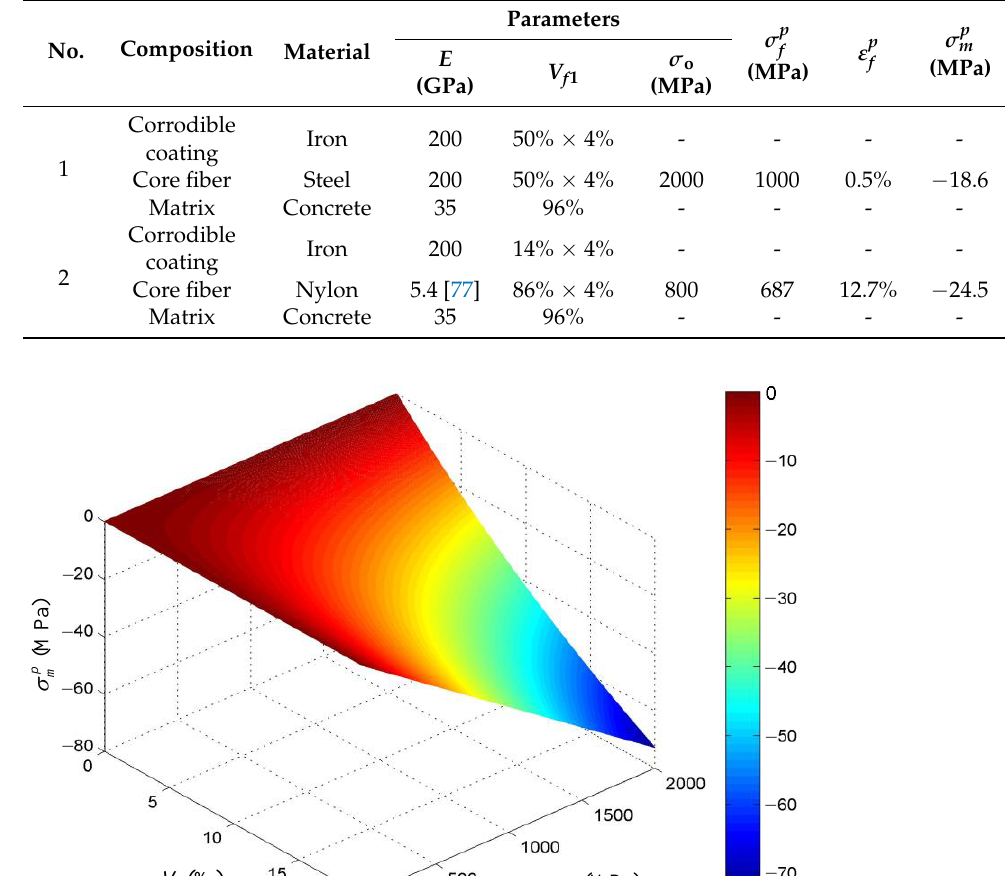
Table 1. Basic material parameters and calculation results of CIF and concrete.